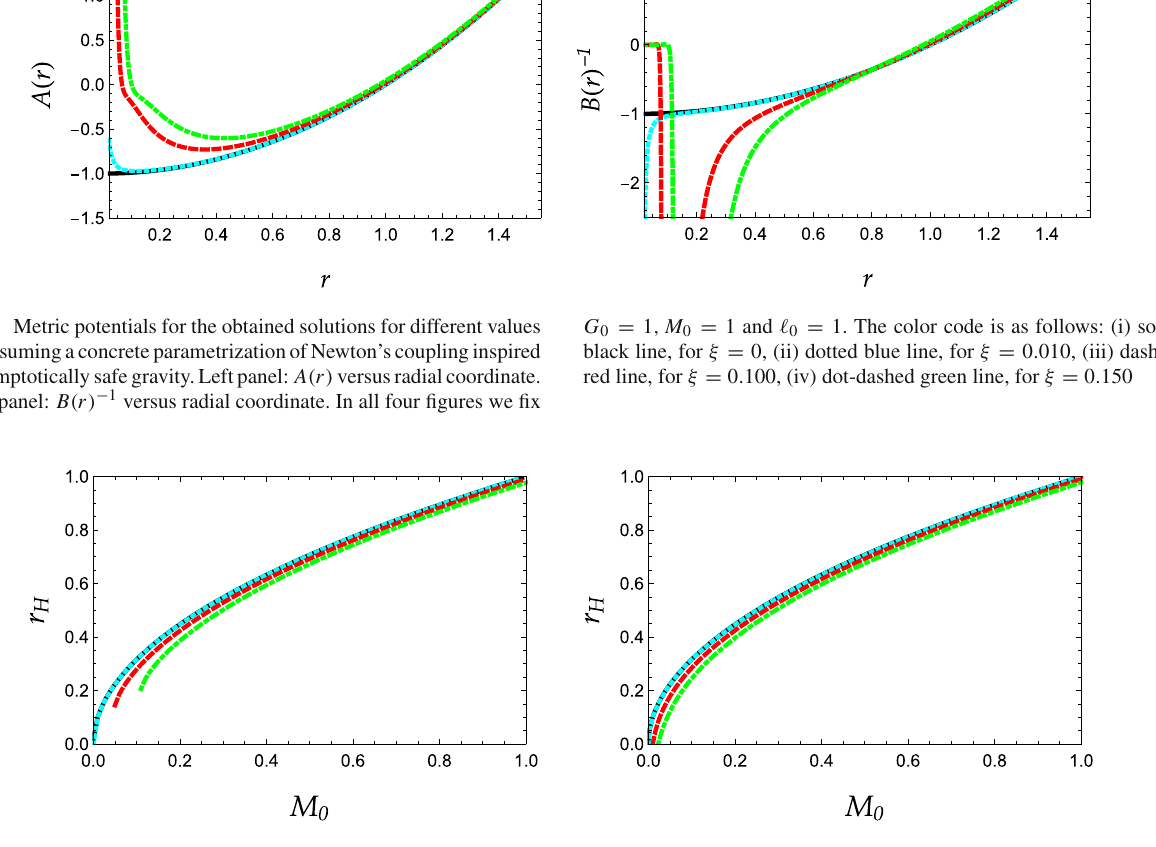
parameter ξ , maintaining just the leading correction. The color code is as follows: (i) solid black line, for ξ = 0, (ii) dotted blue line, for ξ = 0 . 010, (iii) dashed red line, for ξ = 0 . 100, (iv) dot-dashed green line, for ξ = 0 . 150